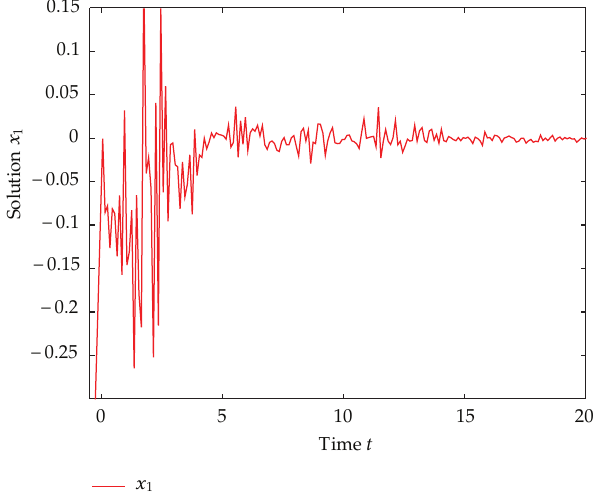
(cid:6) t (cid:7)(cid:7) of system (cid:6) 4.1 (cid:7) . 2